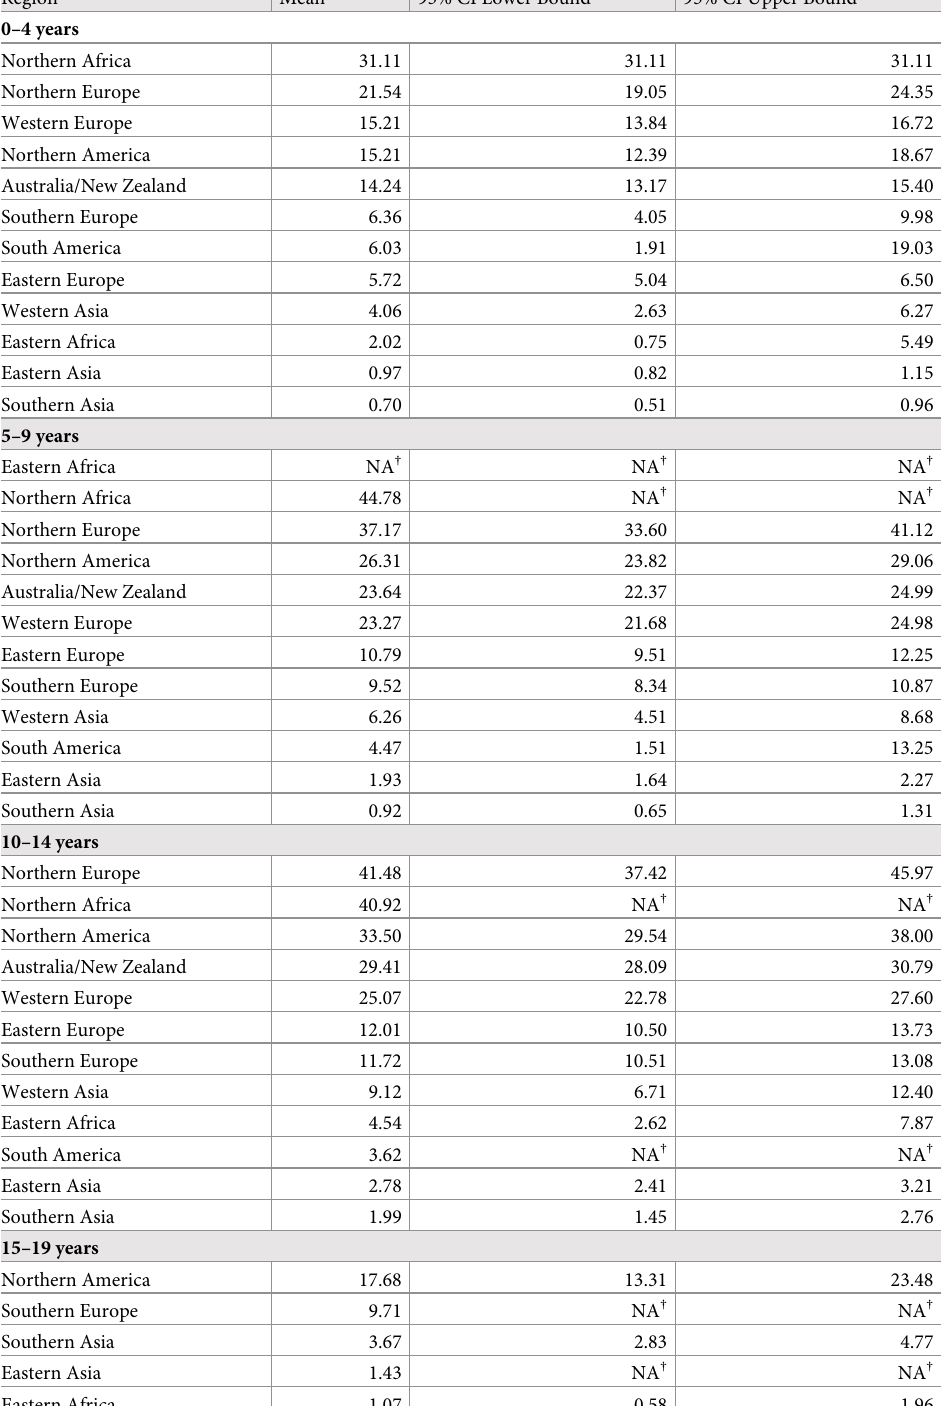
Table 2. Sub-analysis of type 1 diabetes incidence rates based on age category. � (Age-standardised incidence rates per 100,000 individuals per year with 95% confidence intervals. † For cells labeled as NA, 95% CIs could not be esti- mated as there was only 1 data